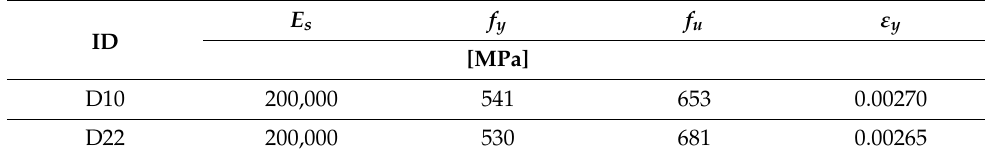
Figure 4. Material test results: ( a ) Compressive stress–strain relation; ( b ) Applied flexural load-CMOD relation; ( c ) Direct tensile stress–crack width relation. Table 4. Mechanical characteristics of used